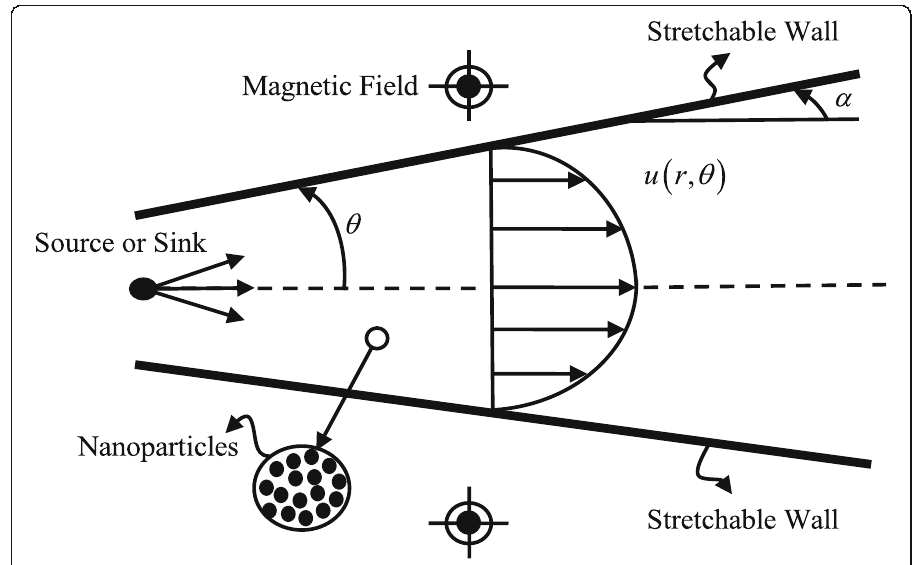
Fig. 1 Geometry of the flow and coordinate